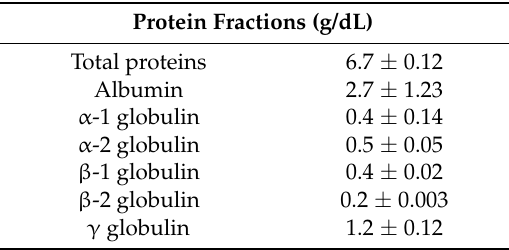
Table 3. Protein fractions were assessed as described in materials and methods and are shown here as mean ± standard error.